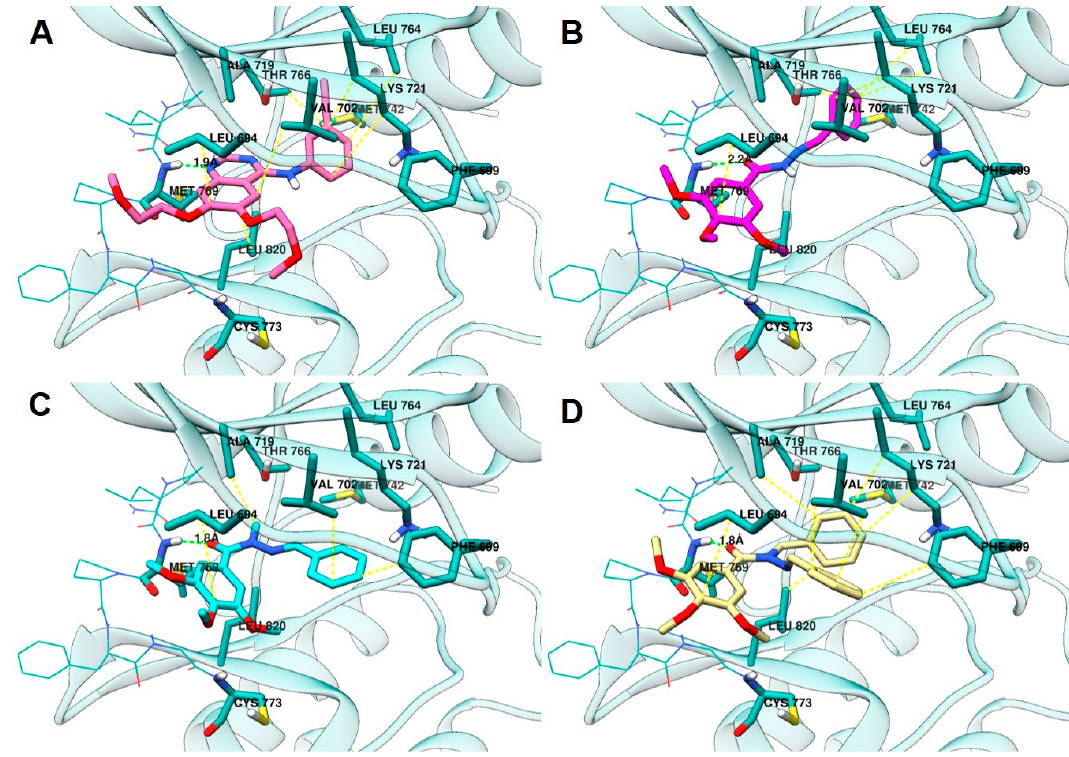
Figure 7. Analysis of the interaction mode in ( A ) erlotinib in pink, ( B ) LASSBio ‐ 1586 ( 2 ) in magenta, ( C ) LASSBio ‐ 1735 ( 3 ) in cyan, and ( D ) LASSBio ‐ 2070 ( 10 ) in yellow, at the ATP binding site (PDB: 1M17). Protein carbon atoms are represented in light blue, oxygen in red, nitrogen in blue and the distances between hydrogen bond are represented by the green line. Hydrophobic interactions are represented by yellow lines.